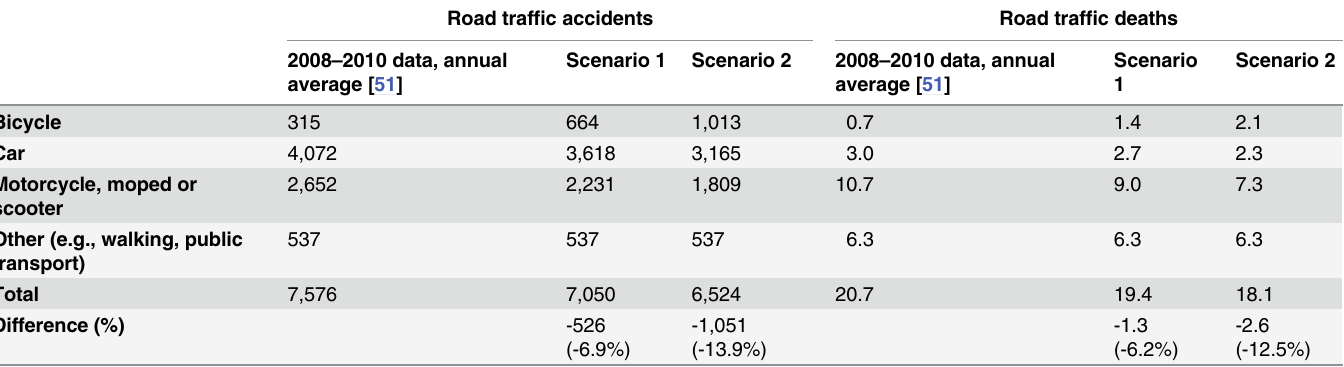
Table 6. Road traffic accidents and deaths by means of transportation, 2008 – 2010 Municipality of Florence data and cycling promotion scenario analysis.